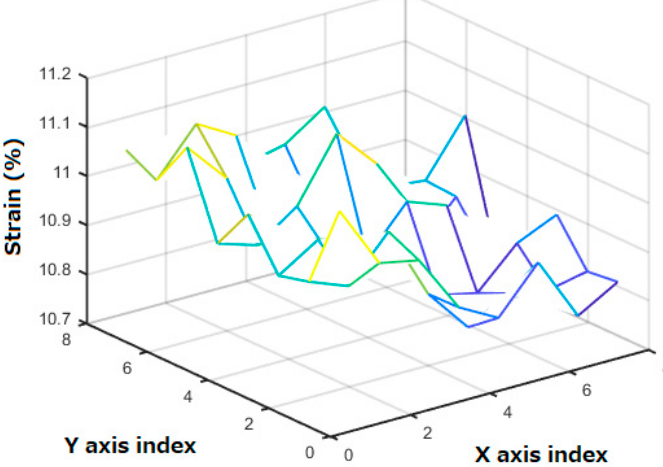
Figure 13. Estimated strain in the selected zone. Figure 12. Estimated strain in the selected zone.